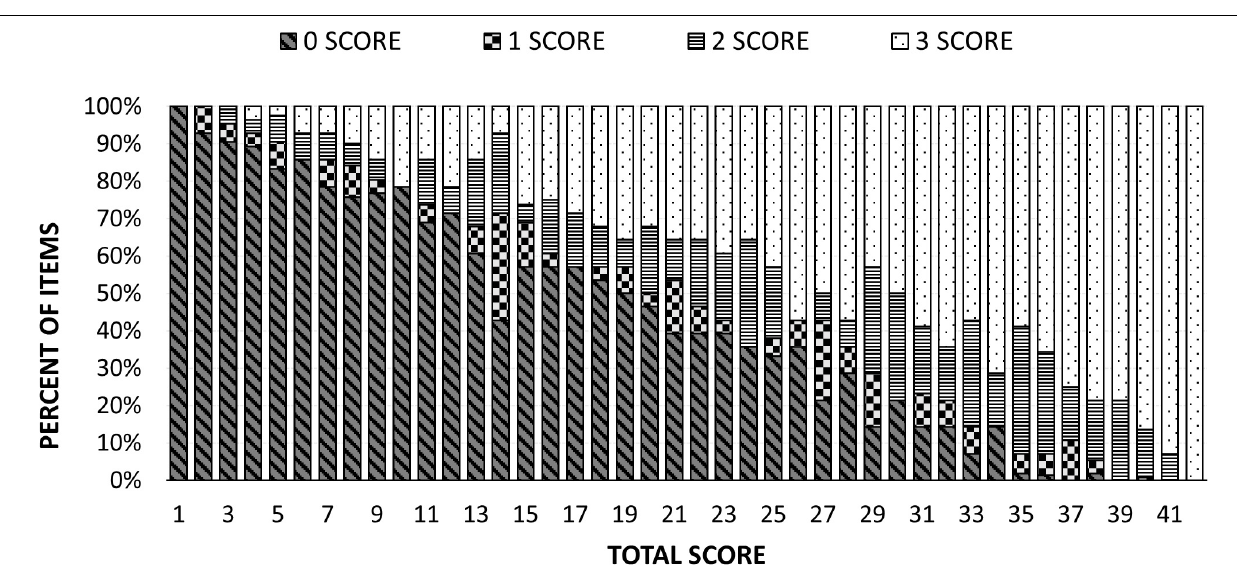
14 items), obtained by pooling over cases with the same total score. As expected, the proportion of 0 scores diminished when total scores increased, whereas the proportion of 3 (completely